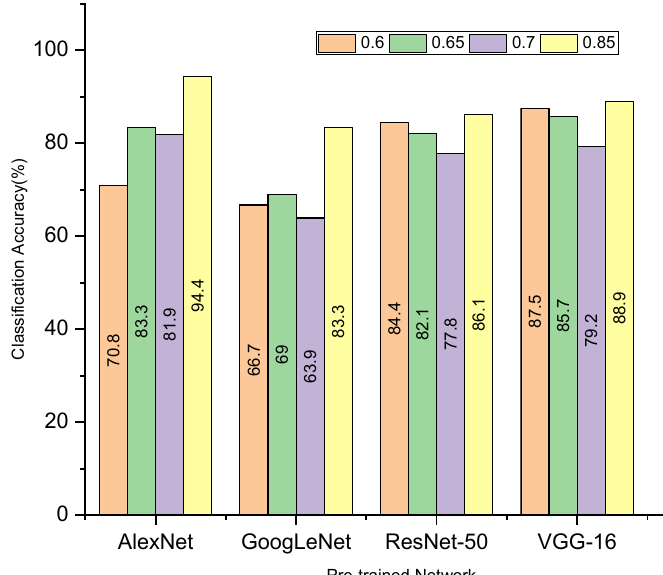
Figure 8. Pretrained network performance with variable TR.